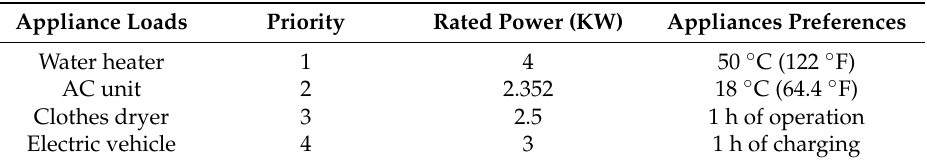
Table 1. Appliances’ rated power and priority.